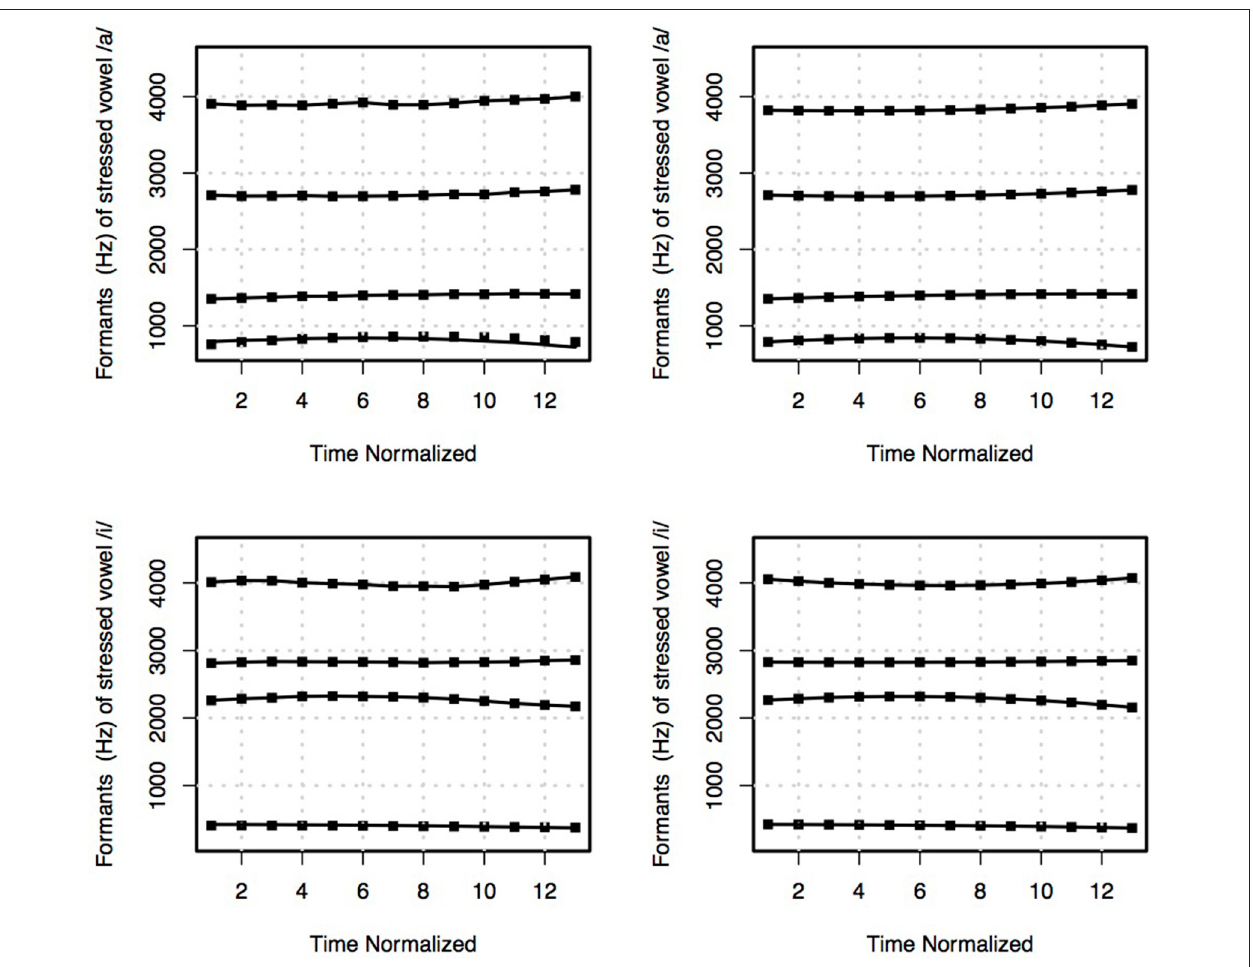
FIGURE 5 | Means of F1 − F4 (in Hz) of the actual vowel productions (Left panels) of the stressed vowels /a/ (Upper panel) and in /i/ (Lower panel) and the models of F1 − F4 (in Hz) that resulted from the polynomial